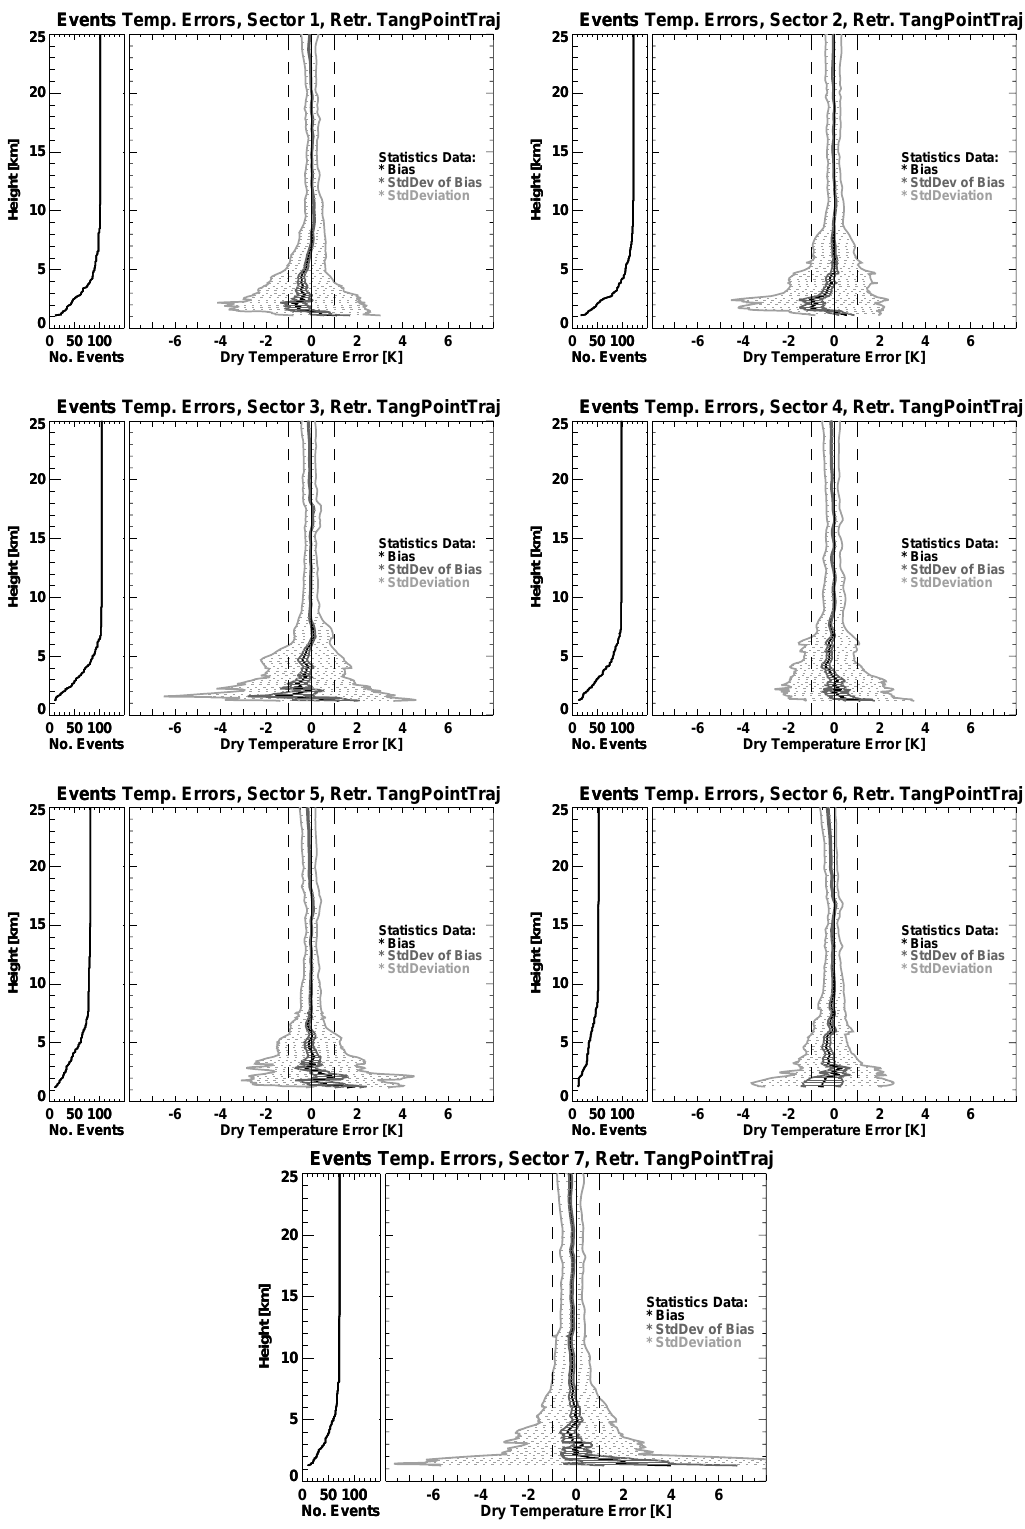
Figure 5. Difference error statistics for dry temperature in sectors 1 – 7, with the “true” profile along the retrieved tangent point trajectory as reference.